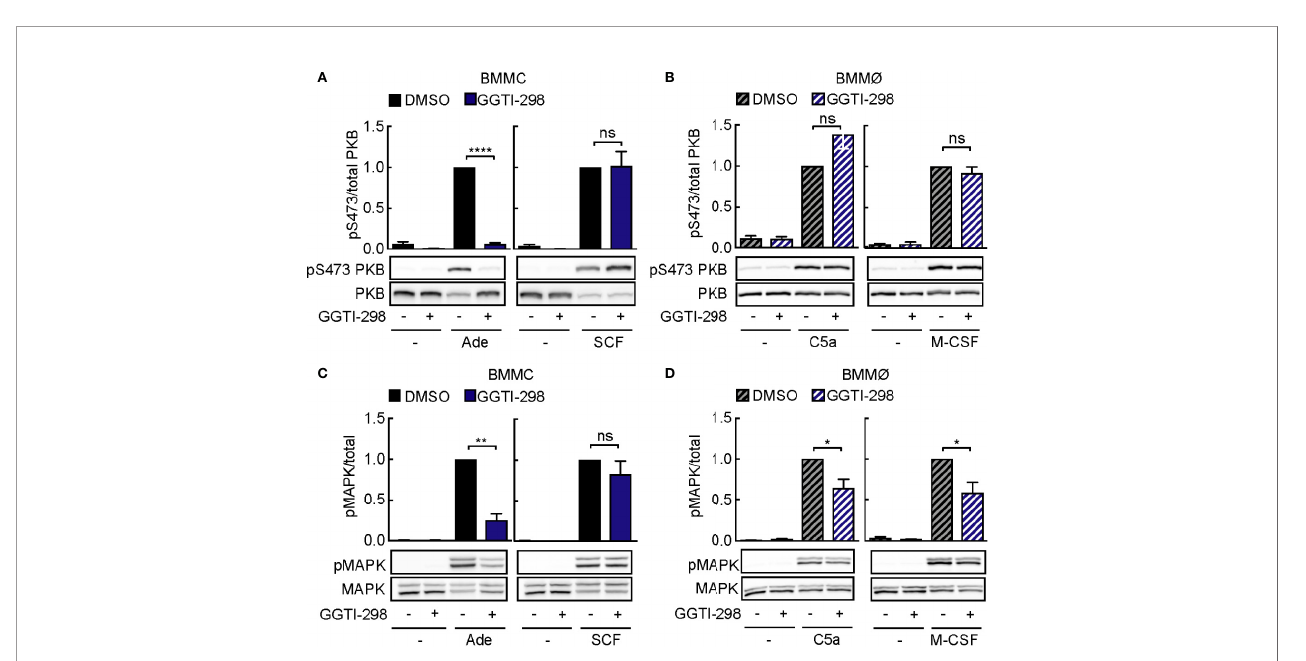
FIGURE 6 | GGTI-298 affects activation of mast cells, but not macrophages. BMMCs (A, C) and BMMØs (B, D) were treated with either DMSO or 5 µM GGTI-298 for 24 h, starved for 4 h and activated with 2 µM Ade, 10 ng/ml SCF, 10 nM C5a or 30 ng/ml M-CSF for 2 min at 37°C. Phosphorylation of PKB (Ser473) and MAPK was determined by immunoblot blot analysis of cell lysates and normalized to the total level of corresponding proteins (n = 4 – 10). Statistical signi fi cances were assessed by Student ’ s